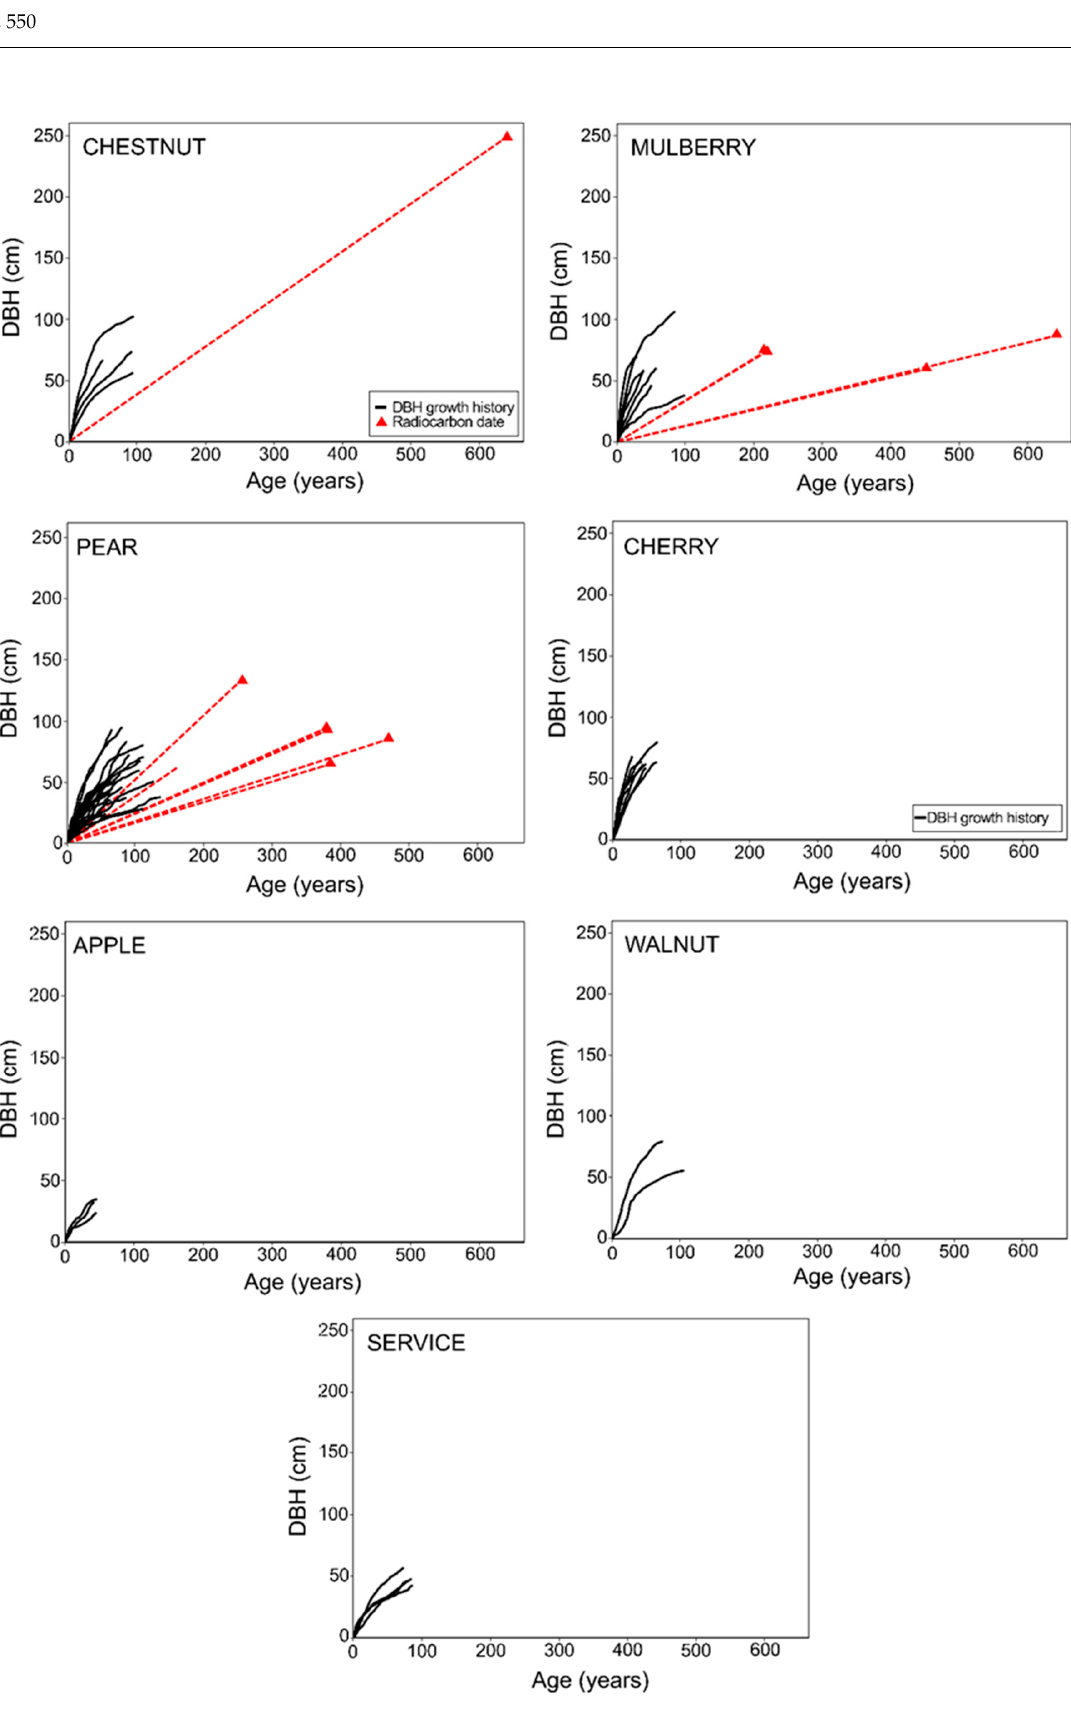
Figure 7. DBH growth histories (black lines) calculated from annual ring-width measured through dendrochronological methods. Radiocarbon ages of chestnut, mulberry and pear trees (red triangles) were included for reference and used to simulate linear growth (dashed red lines).